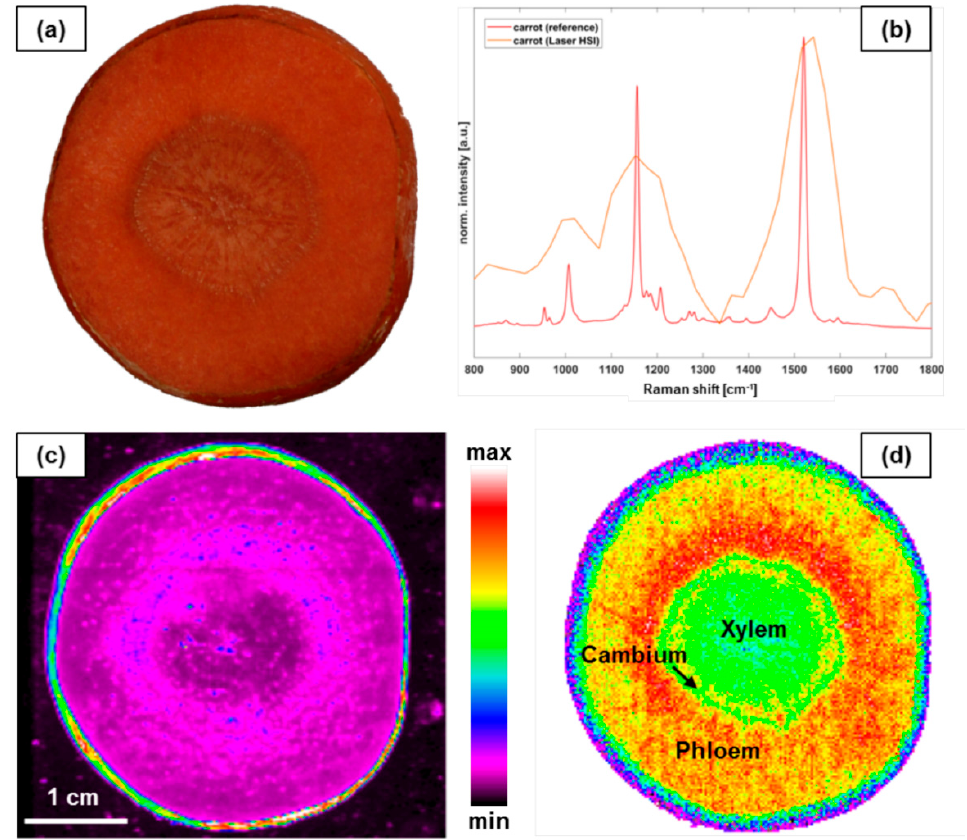
Figure 3. Laser-HSI of the carrot slice. ( a ) Picture of the carrot slice. ( b ) Normalized example spectra of the carrot slice from the phloem and reference spectra acquired with the Raman microscope. ( c ) False color image of the measured intensity at ~1000 cm − 1 before any pre-processing of the spectra. ( d ) Color-coded relative intensity of the carotenoid peak at 1521 cm − 1